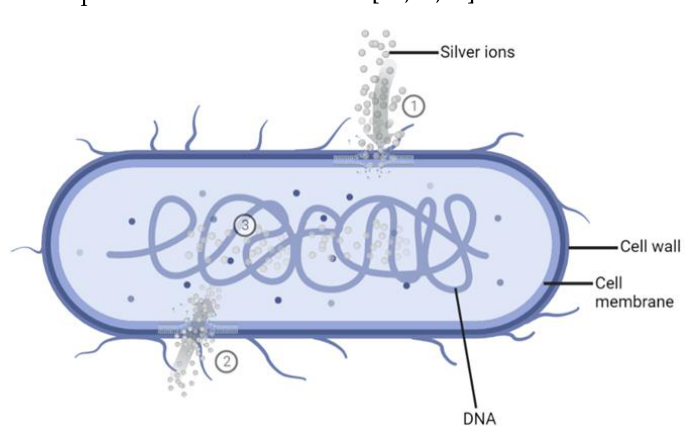
Figure 1. Schematic representation of the mode of action of silver ions (Ag + ). ① . The binding of Ag + to bacterial cell walls and membranes blocks the transport of essential substances. ② . Cellular uptake of Ag + leads to the binding and inactivation of enzymes. ③ . The interaction of Ag + with bacterial DNA and blocking its cell division. Created with BioRender.com.